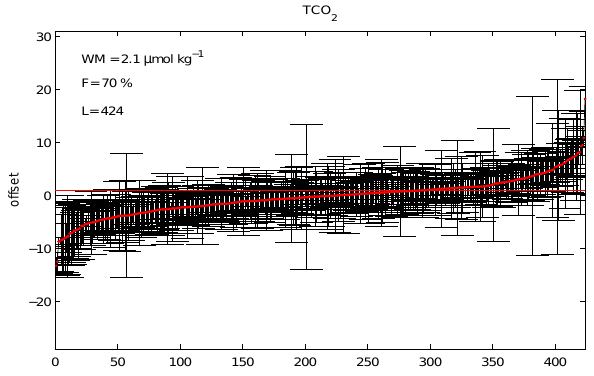
Figure 7. O ff sets in TCO 2 ( µ molkg − 1 ) in ascending order (Num- ber) from left to right calculated for the crossovers in the CARINA- ATL data after adjustments have been applied. WL: the weighted mean of the o ff sets (see text); F : the percentage of o ff sets in- distinguishable from 1 within their uncertainty; L : the number of